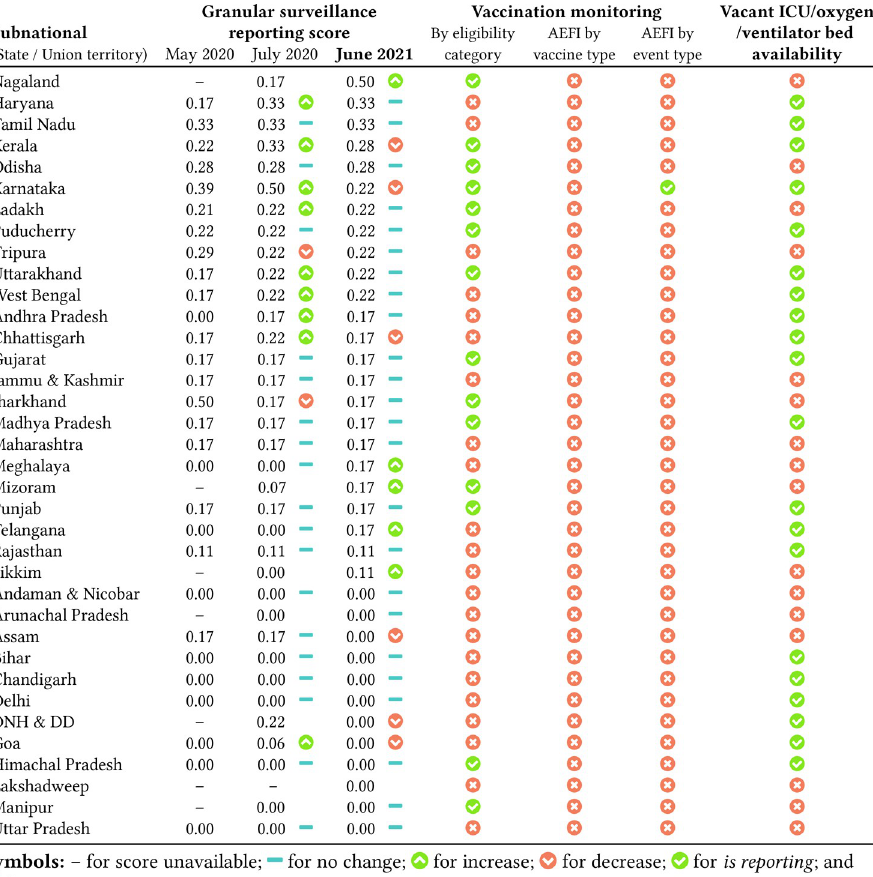
Fig 2. Subnationals sorted in the decreasing order of granular surveillance reporting score from the current assessment (June 2021). The scores from previous assessments (2020) are shown for comparison [7, 8]. The table also shows which subnationals are reporting (or not) vaccination coverage stratified by eligibility category; AEFI stratified by vaccine and event type; and vacant ICU/oxygen/ventilator bed availability disaggregated by districts/hospitals.